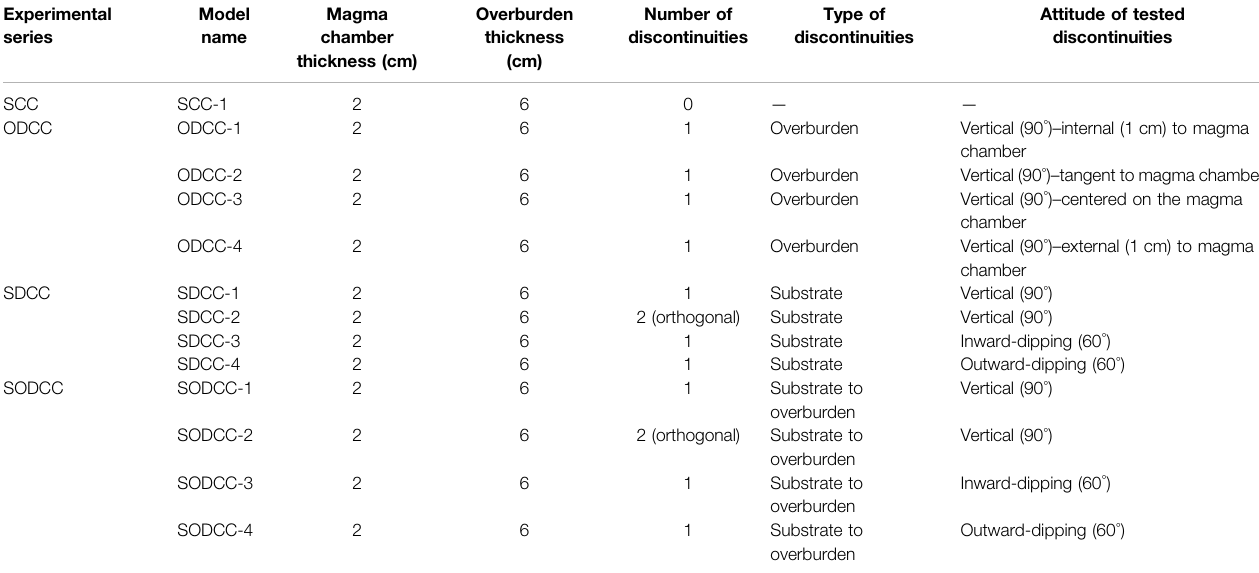
TABLE 1 | Summary of adopted model parameters. Each model aimed to test speci fi c characteristics of the inherited discontinuities. Experimental